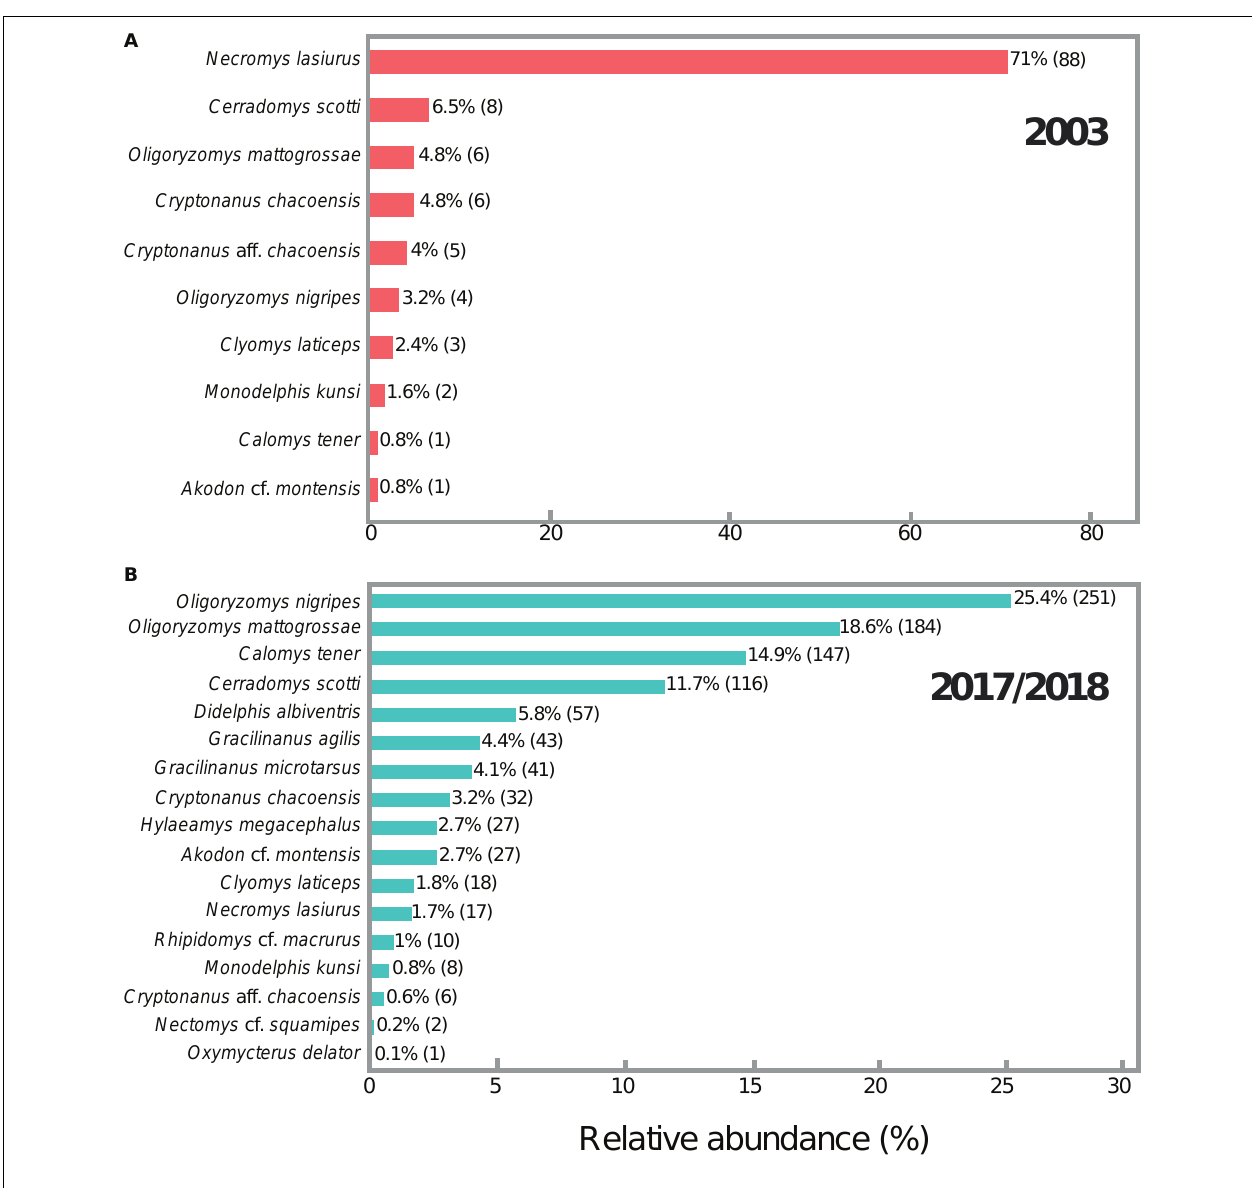
FIGURE 2 | Relative abundances and number of individuals (in parentheses) of small mammals from SBES captured in (A) 2003 survey (3,045 trap-nights) and (B) 2017–2018 survey (23,040 trap-nights).